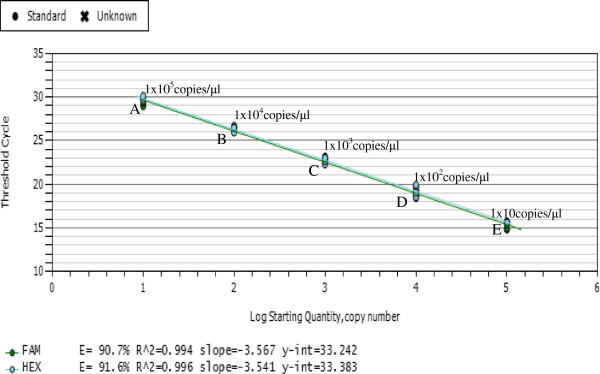
Detection limits and amplification efficiency of duplex RT-qPCR. Detection limits and amplification efficiency of the multiplex RT-qPCR for detection of RBSDV and SRBSDV. The standard curves were established by five gradient, in which every gradient contained 3 replicates in duplicate of a 10-fold dilution series containing mixed standard ssRNA of RBSDV and SRBSDV at: 1x105 (A); 1x104 (B); 1x103 (C); 1x102 (D); 1x10(E) template copies per reaction.